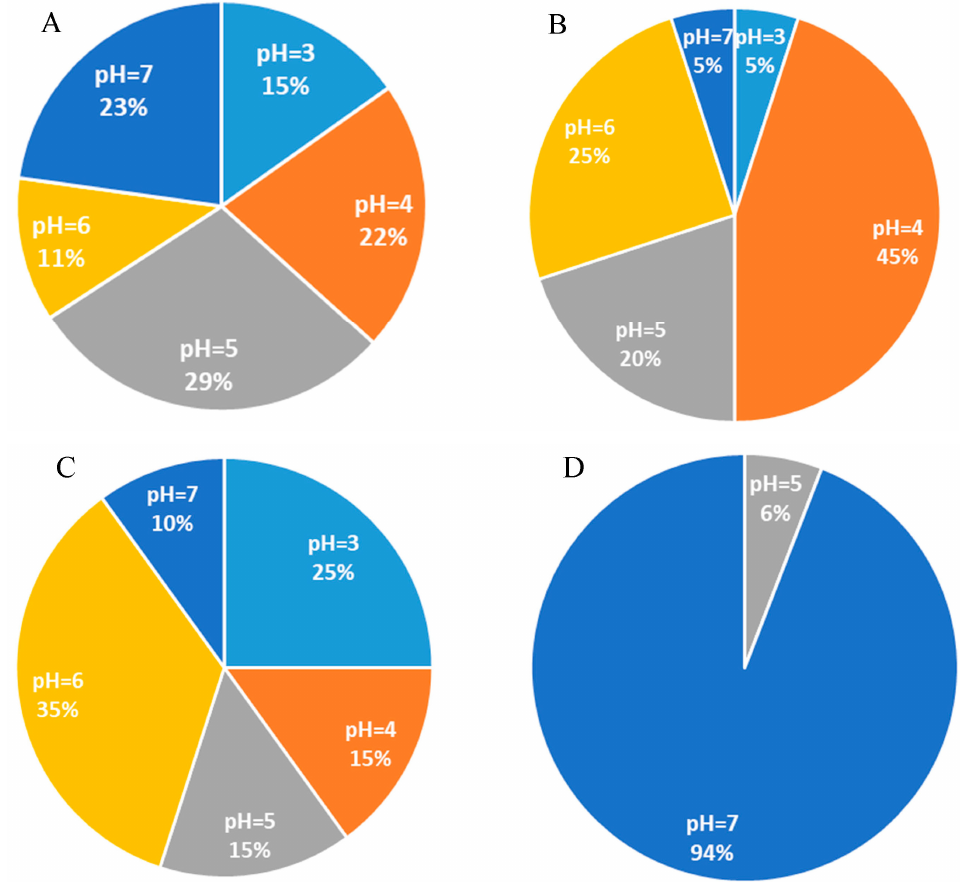
Figure 8. Relationship between dominant bacterial genera and pH of enriched culture conditions. ( A ) Bacillus, ( B ) Acetobacter, ( C ) Microbacterium, and ( D ) Rummeliibacillus.